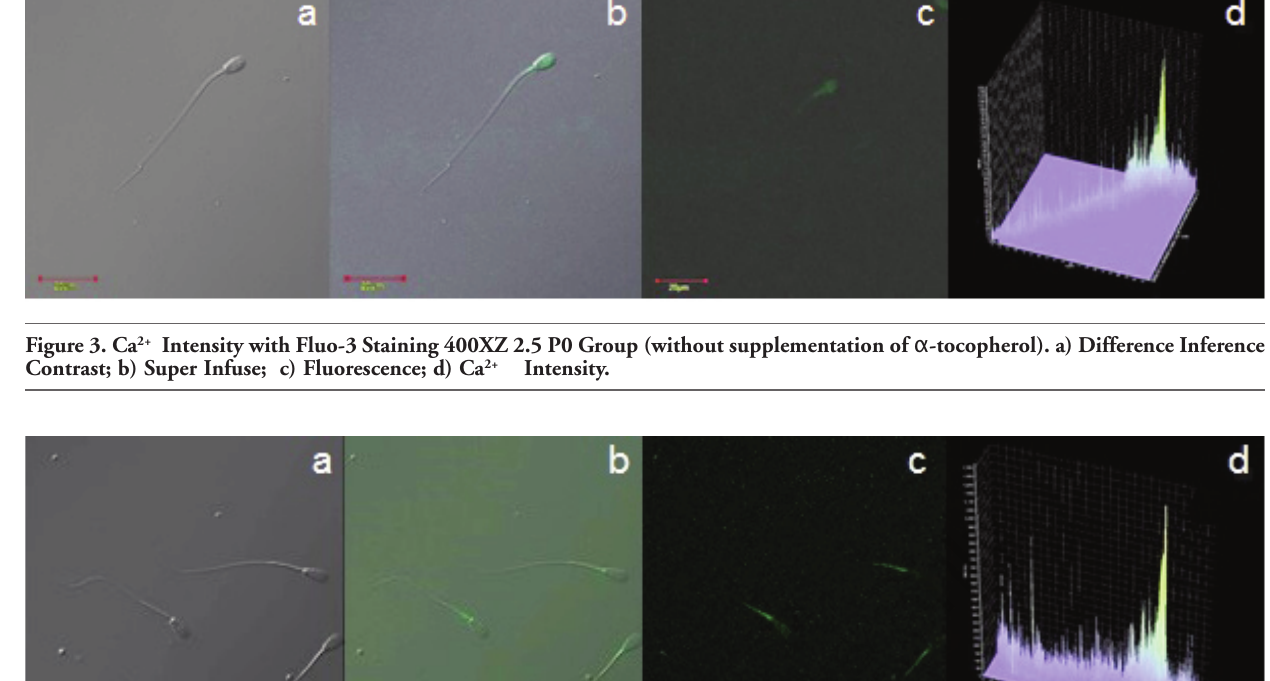
-tocopherol): a) Difference α